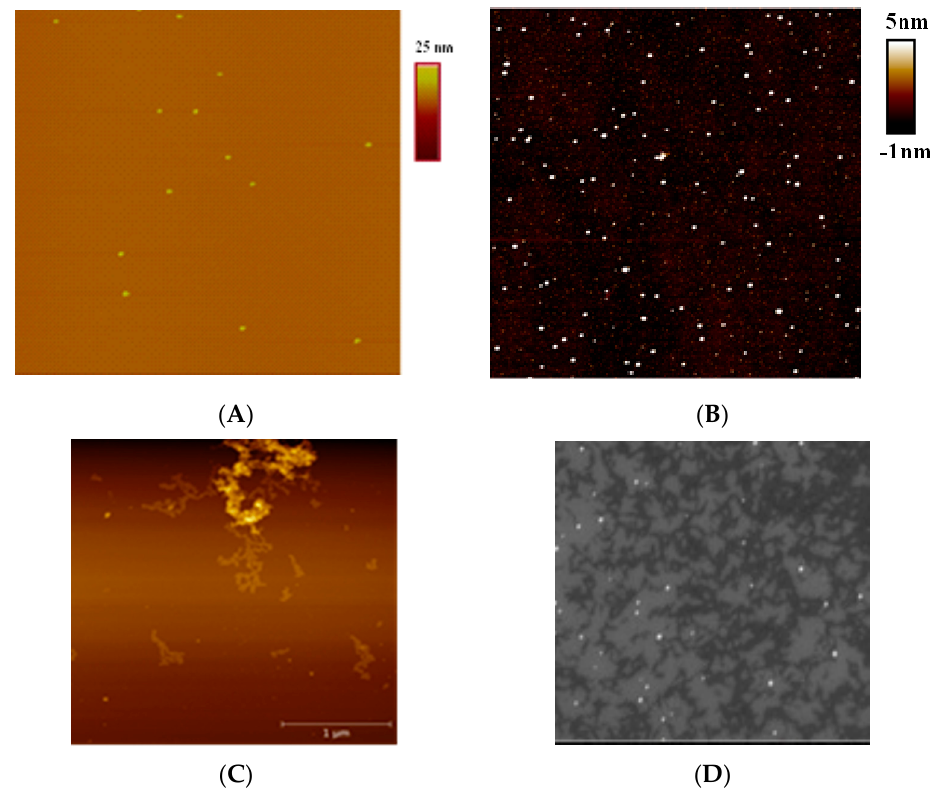
Figure 8. The result of silver reduction in: AgNO 3 ( A ); and Ag–Phen ( B – D ) solutions. AFM ( A – C ); and SEM ( D ) images of nanoparticles on silicon after their fixation from the solution with С (Ag–Phen) = 2 × 10 − 5 M ( A , C , D ) and 8 × 10 − 5 M ( C ) at С (NaBH 4 ) = 1.25 mM. ( A , C , D ) Images have a size 3 μ m × 3 μ m, ( B ) image has a size 5 μ m × 5 μ m.